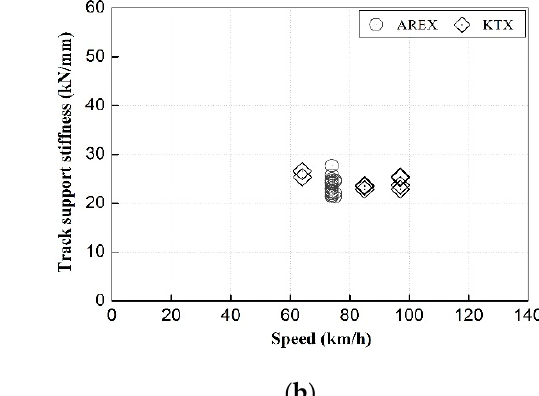
Figure 14. Measured wheel load–track displacement according to train type. ( a ) Before rail pad replacement and ( b ) after rail pad replacement.